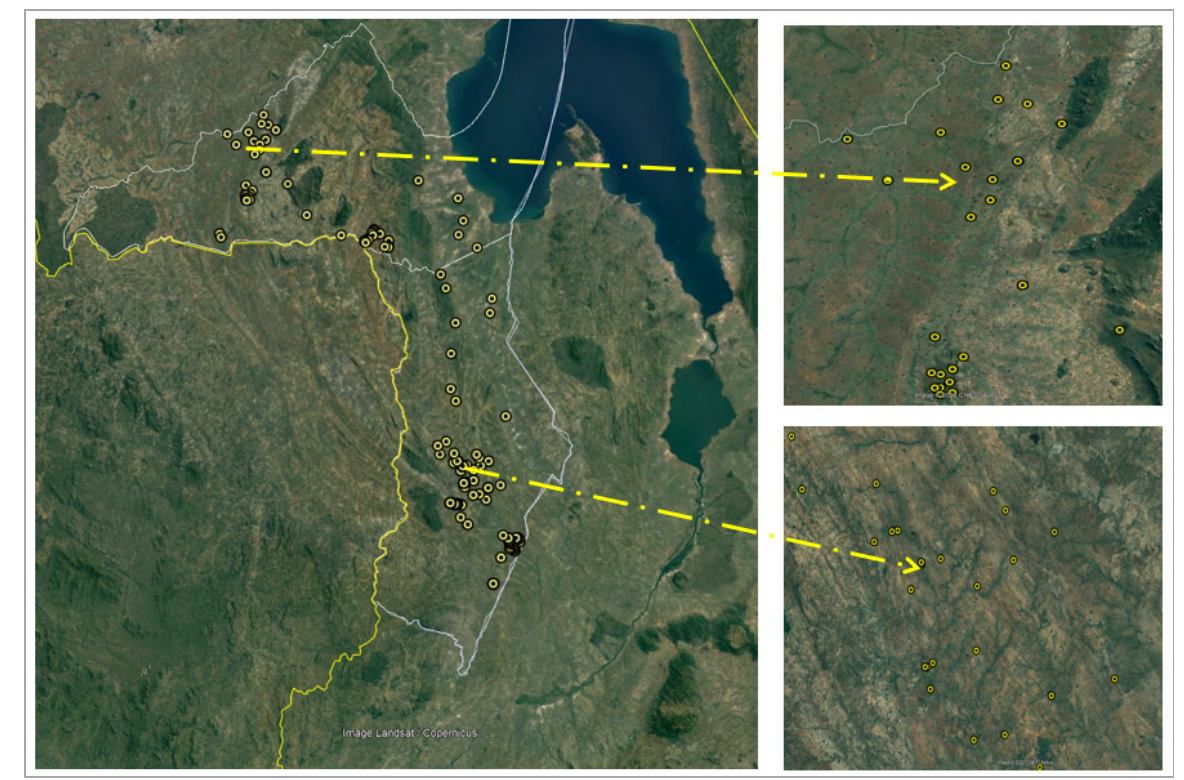
Figure 2. Google Earth Explorer map showing location points collected during field observations ground truthing for Dedza and Ntcheu Districts in Summer 2018.